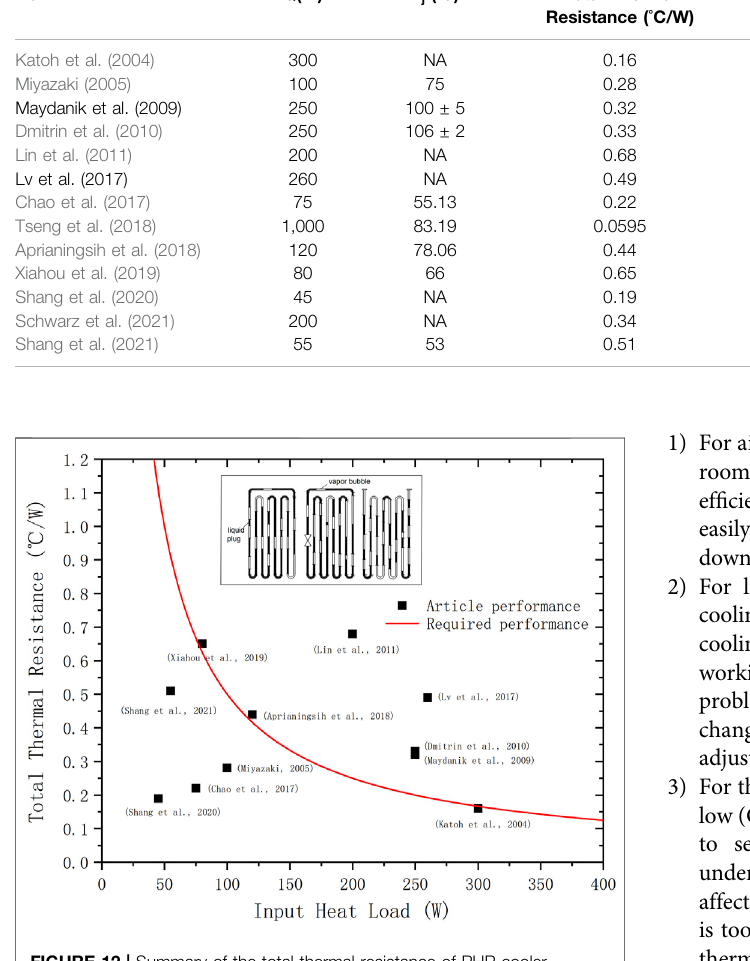
FIGURE 12 | Summary of the total thermal resistance of PHP cooler from different